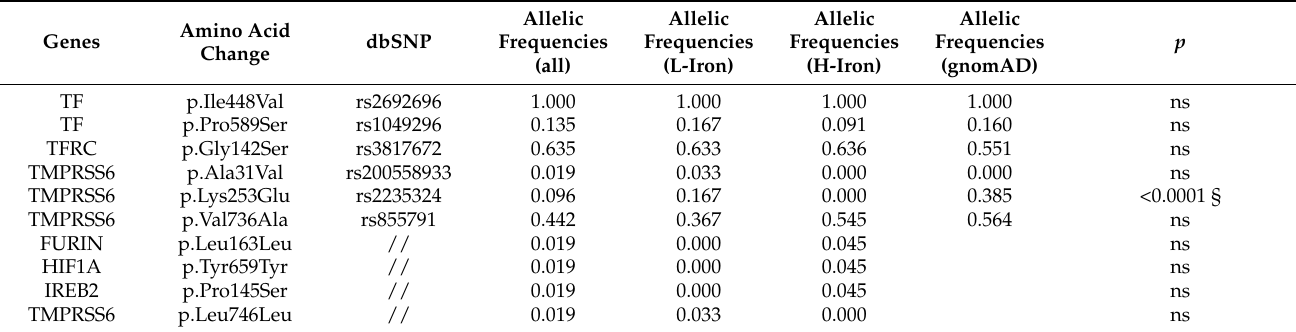
Figure 2. Western blot of lysates of Huh-7 cells transfected with WT vectors in normoxia and chemically induced hypoxia (WT + Co), and with P582S and A588T vectors. β -Actin was used as a loading control. Table 4. HIF1A , VEGF , HMOX , FUR and TMPRSS6 mRNA levels expressed as the ratio between transfected and non-transfected Huh-7 cells under normoxic and hypoxic (+) conditions. All data were obtained from three independent experiments conducted in triplicate (mean ± SD). WT + Co